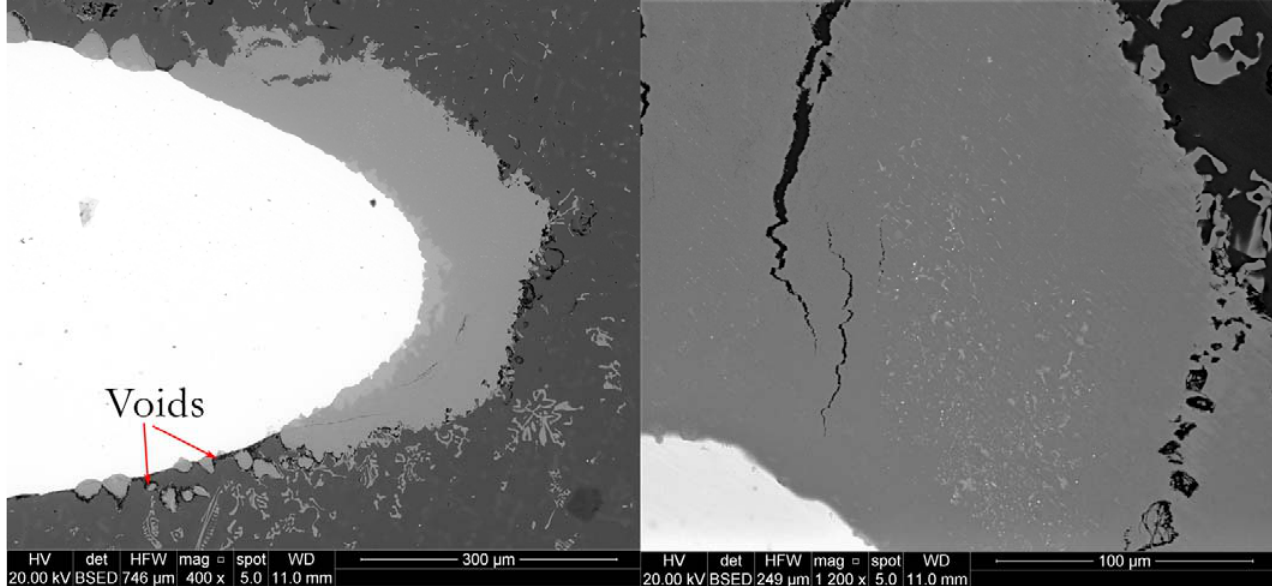
Figure 9: SEM micrographs of the intermetallic layer after solution treatment (500 °C,